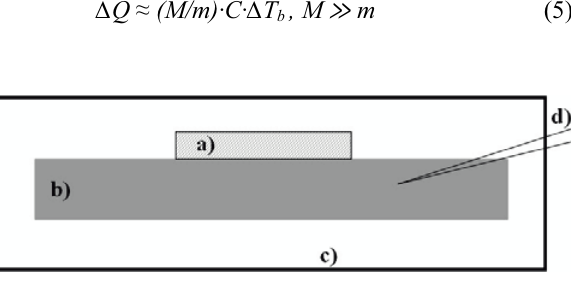
Figure 1. Scheme of direct experimental ΔQ-measurements: a) the sample with MCE, b) the massive nonmagnetic block; c) the vacuum chamber; d) the temperature sensor (diode).